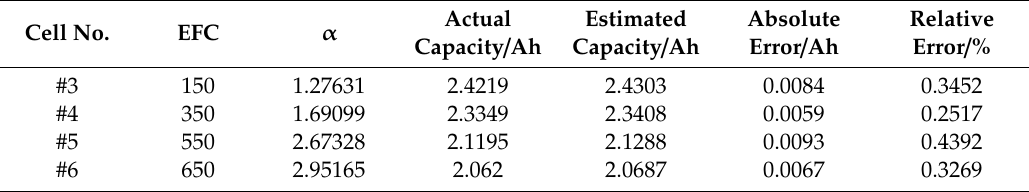
Table 3. Estimated results of α -based capacity estimation method at 70% SOC under charging condition. Cell No.